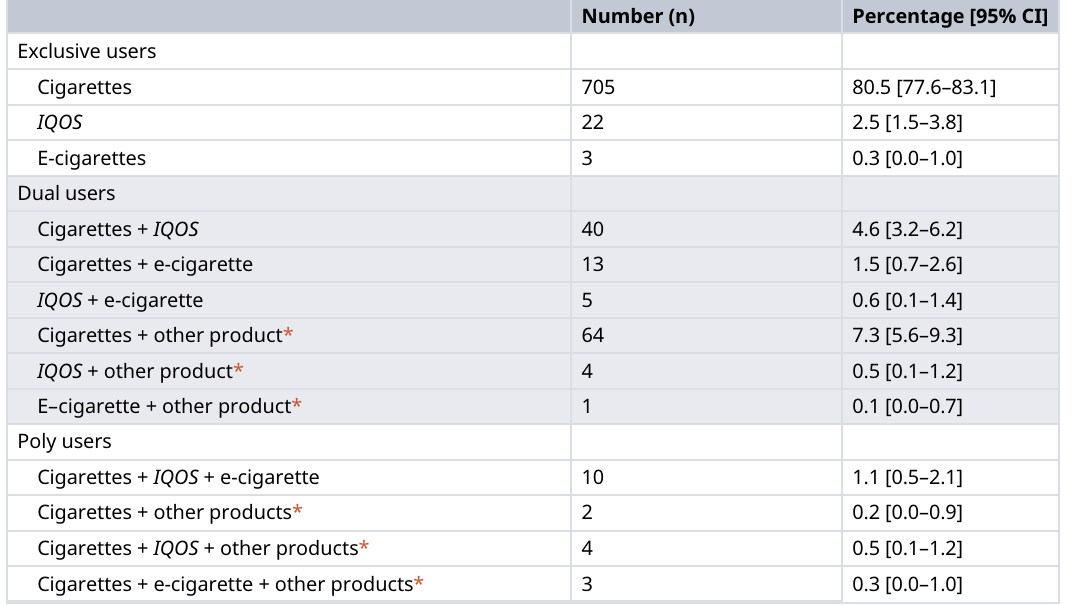
Table 3. Distribution of patterns of use among current TNP users (n=876) in the general population